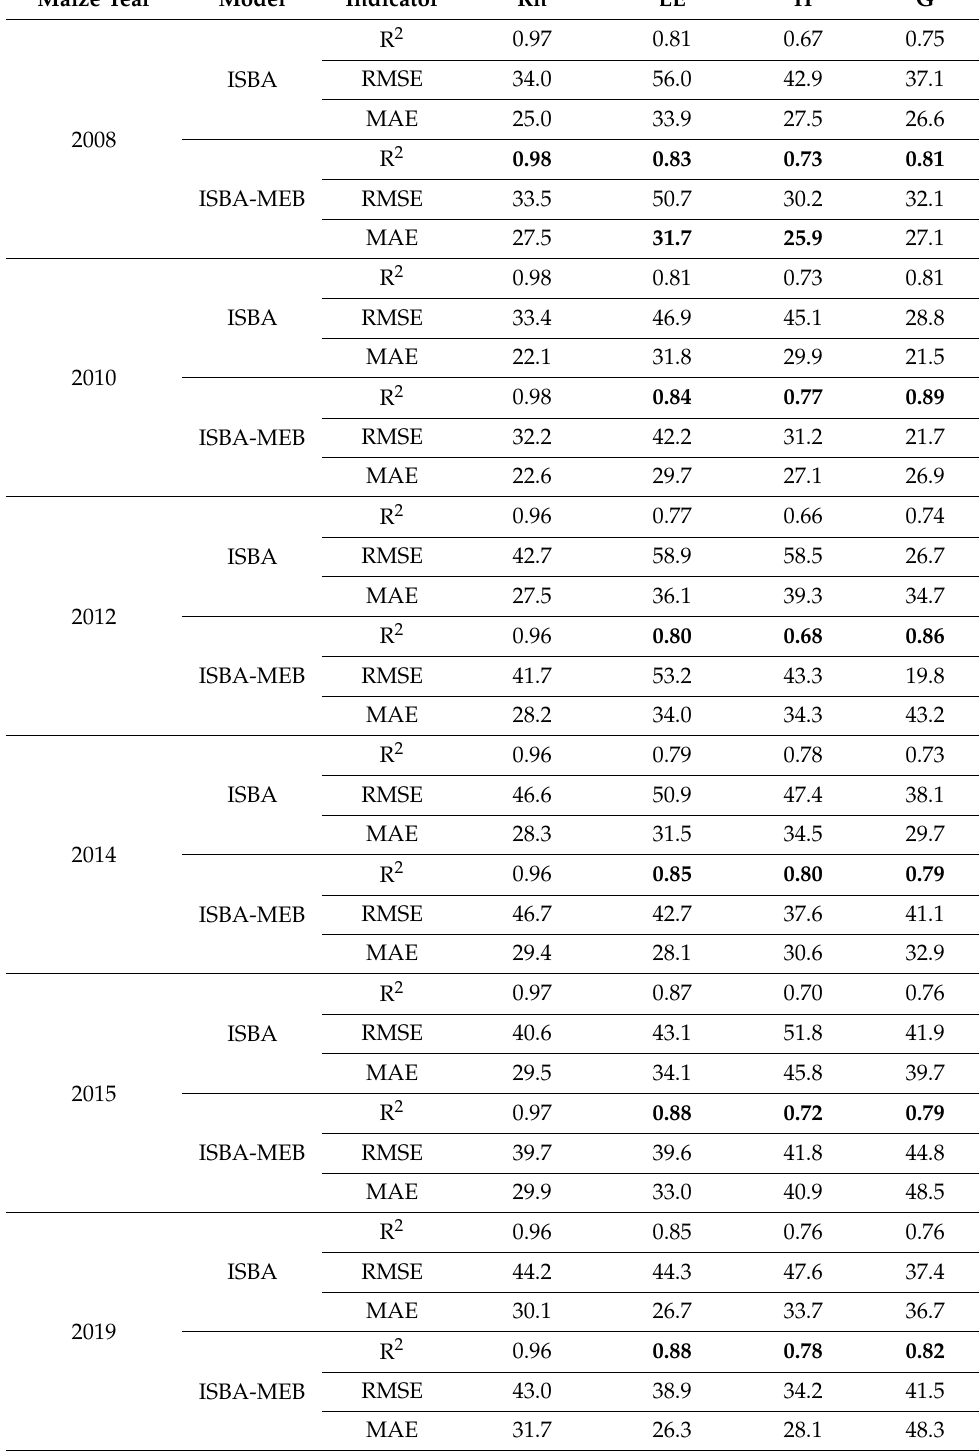
Table 4. Statistical metrics comparing the energy budget components estimated by ISBA and ISBA- MEB against in situ measurements (units of RMSE and MAE in W m − 2 ) at half-hourly time step. In bold fonts are cases when ISBA-MEB gave better scores (R 2